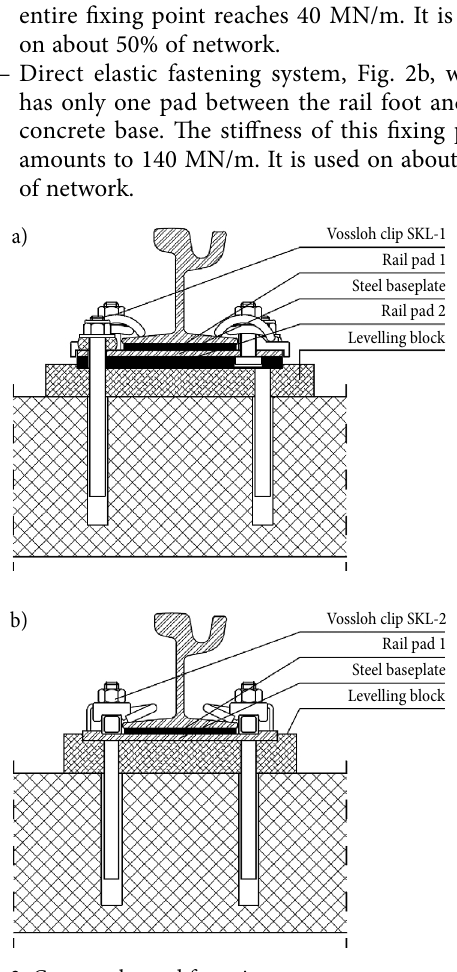
Fig. 2. Commonly used fastening systems on tram tracks in Zagreb (a) indirect elastic fastening